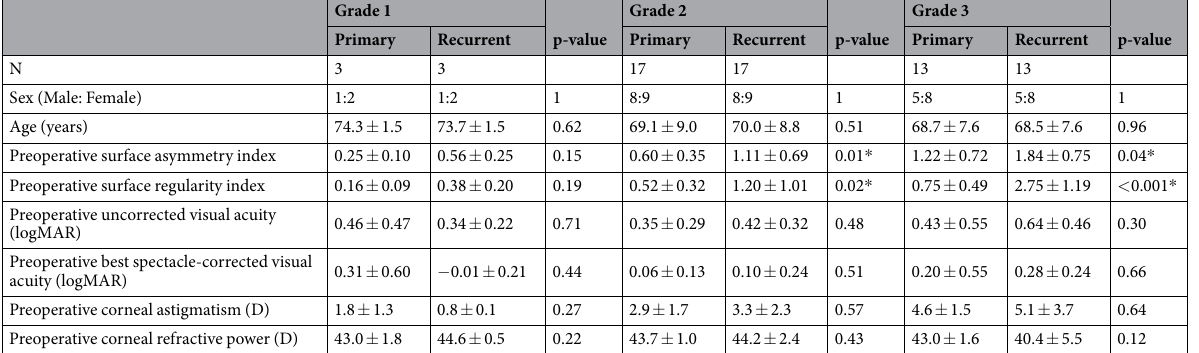
Table 1. Characteristics of patients with each pterygium size. * p < 0.05. logMAR: logarithm of the minimum angle of resolution, D: dioptres. All values are presented as mean ± standard deviation.